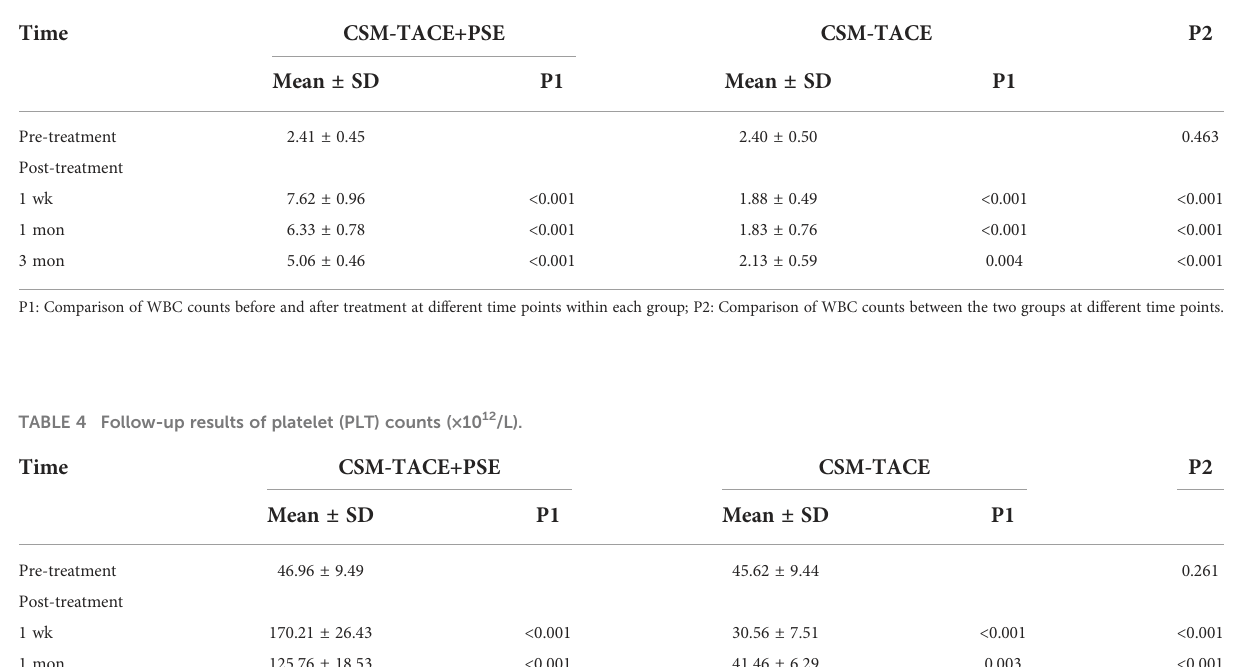
TABLE 3 Follow-up results of white blood cells (WBC) counts (×10 9 /L).